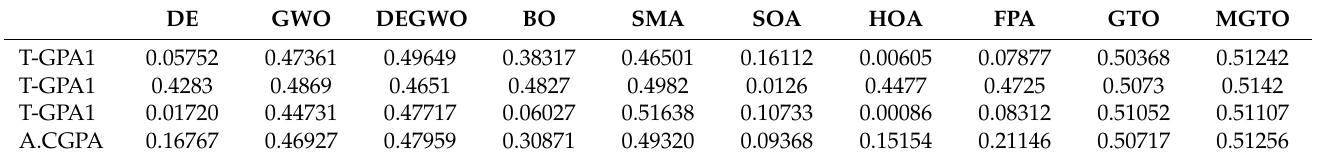
Table 12. Comparison under CGPA on three test